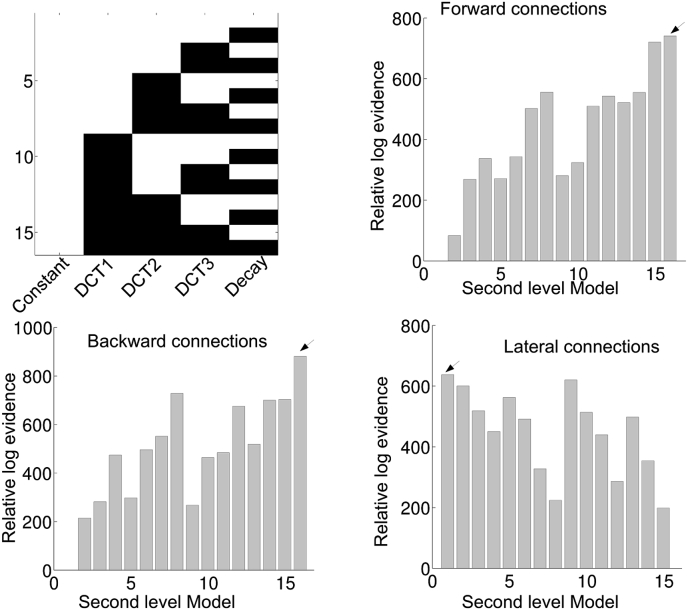
Same format as for Fig. 3. but now for the saliency network.